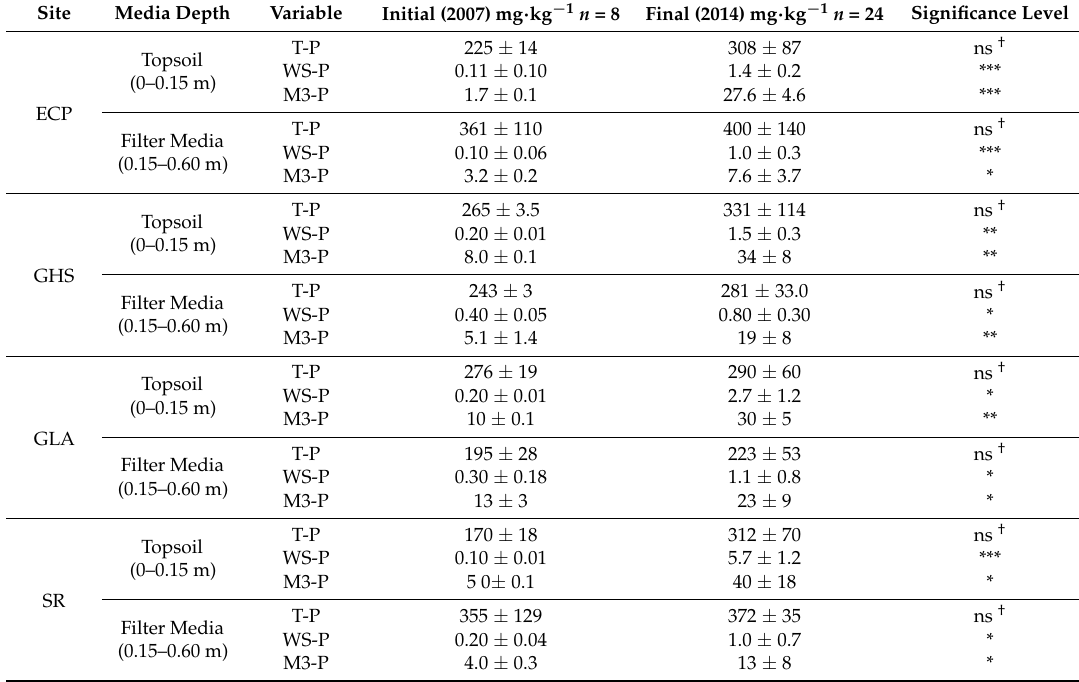
Table 2. Phosphorus concentration (mean ± SD) in topsoil (0–0.15 m) and filter media (0.15–0.60 m) for 2007 and 2014 samples in bioretention cells at Grove,